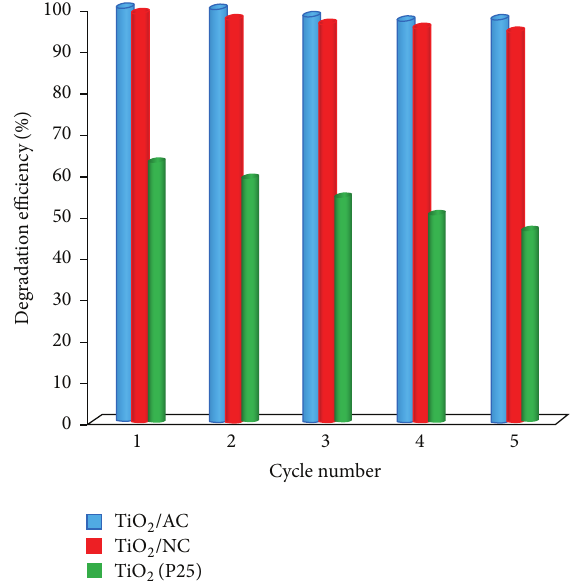
Figure 10: MG degradation by repeated use of the prepared photocatalysts (initial concentration of MG = 75 mg, photocatalyst amount = 0.75 g, and irradiation time = 180